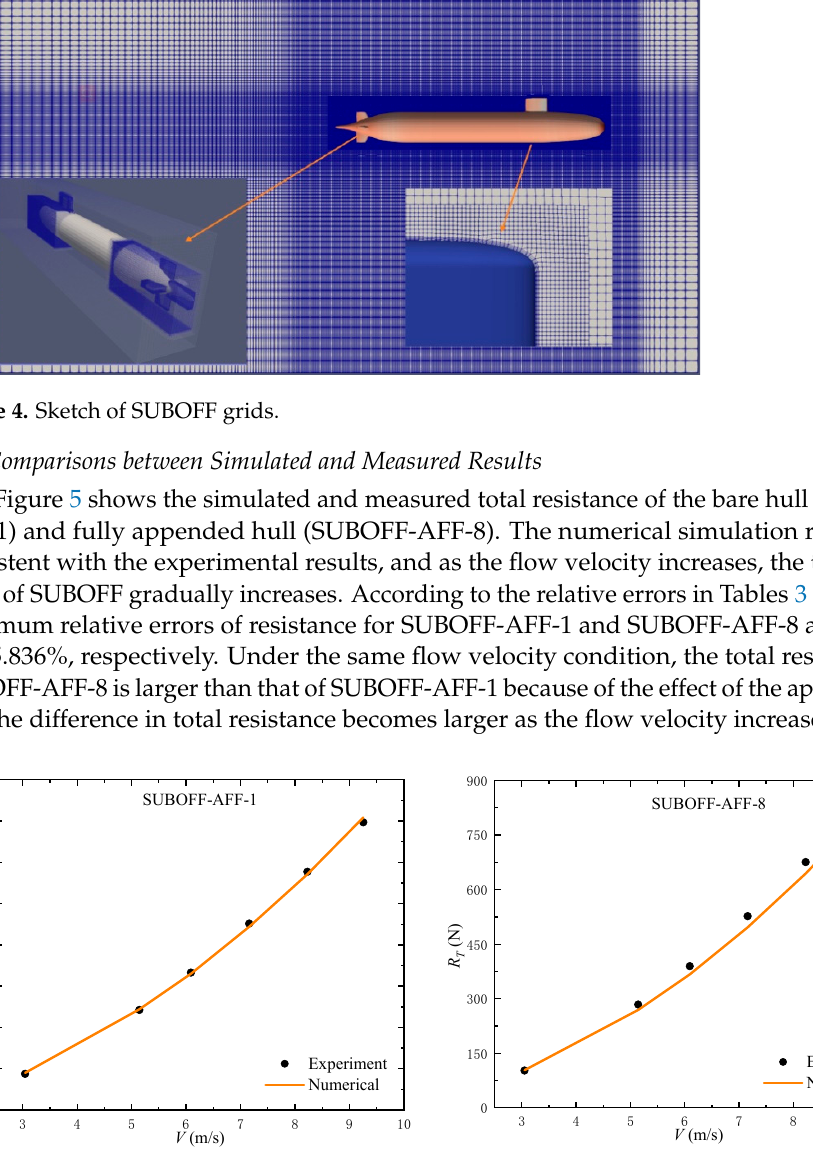
Figure 5. Comparison of the simulated and measured total resistance for SUBOFF. Table 3. Relative error of numerical and experimental resistance values for SUBOFF-AFF-1. Velocity (m/s)